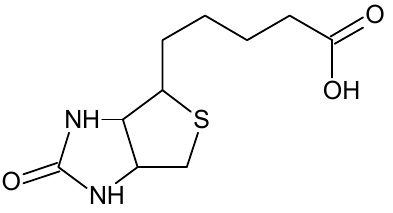
Figure 34. Biotin chemical structure [185].